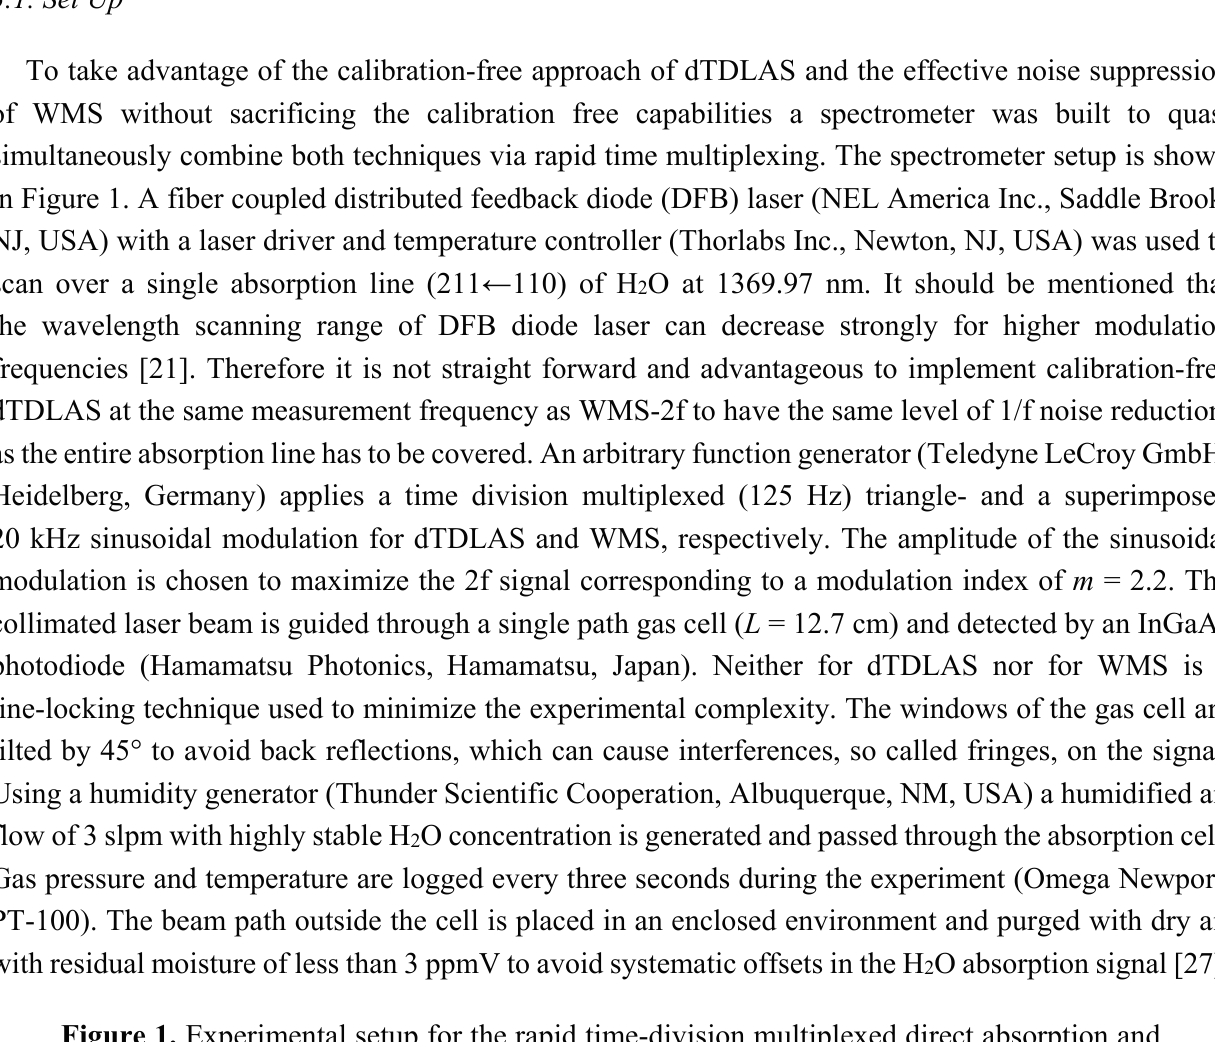
Figure 1. Experimental setup for the rapid time-division multiplexed direct absorption and wavelength modulation